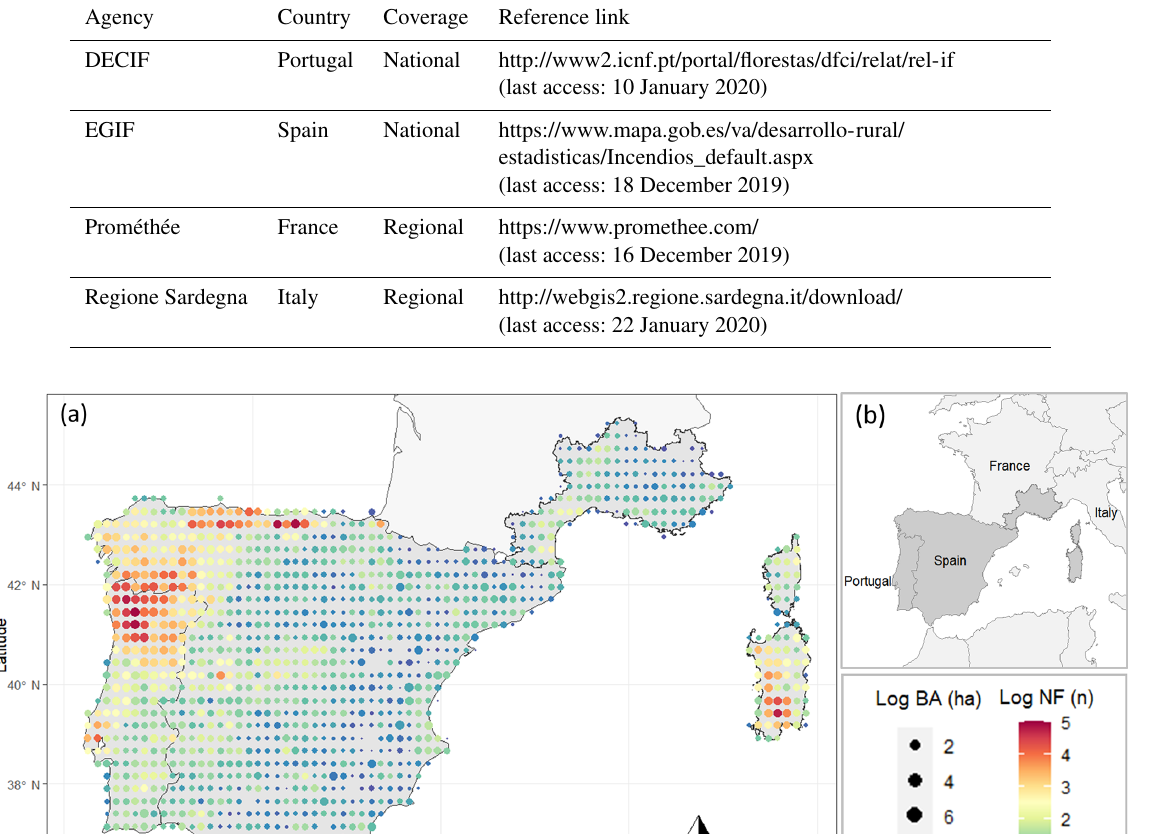
Table 1. Fire agencies and reference links to the data used to build the harmonized ground-based dataset (GBD) across the southwest Mediterranean Basin.